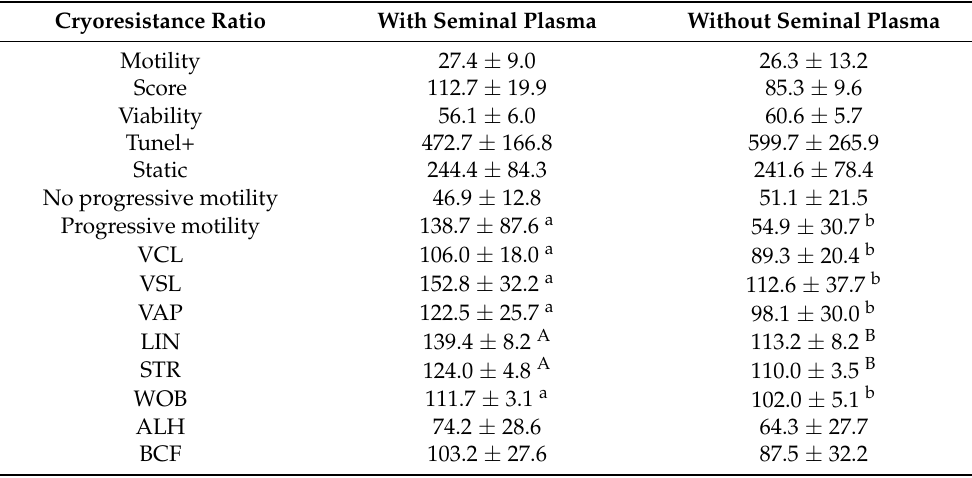
Table 4. Cryoresistance ratio of American flamingo sperm variables frozen with or without seminal plasma. Cryoresistance Ratio With Seminal Plasma Without Seminal Plasma Motility 27.4 ± 9.0